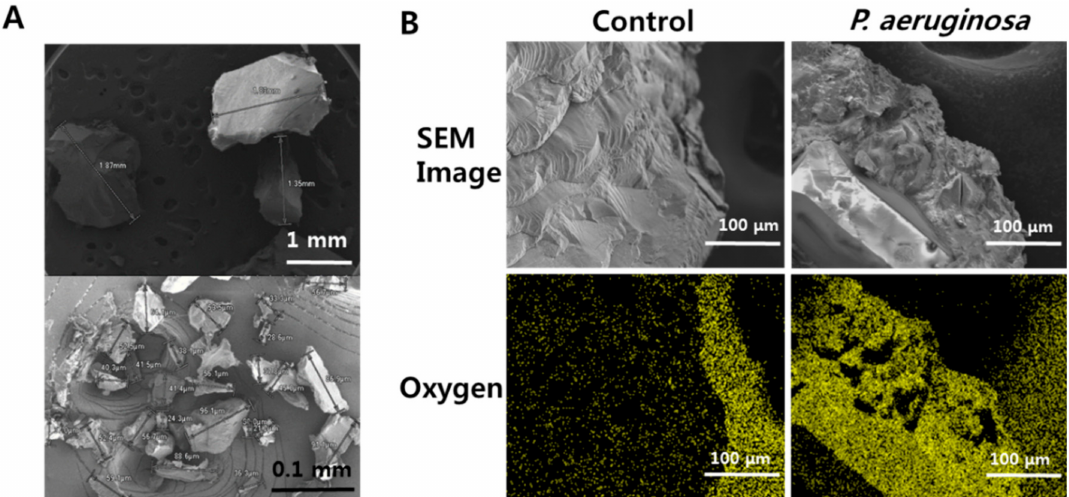
Figure 2. SEM analyses of PS beads biodegraded by P. aeruginosa. ( A ) Comparison of size reduction between PS beads biodegraded by P. aeruginosa (lower) and PS beads without bacteria (upper). ( B ) Detection of oxygen insertion on surfaces of PS beads. The yellowish-green color represents oxygen atoms in control without bacteria (left) and on beads biodegraded by P. aeruginosa